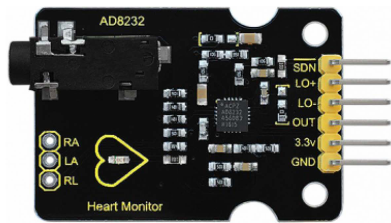
Figure 4. Electrocardiographic biosensor: AD8232.